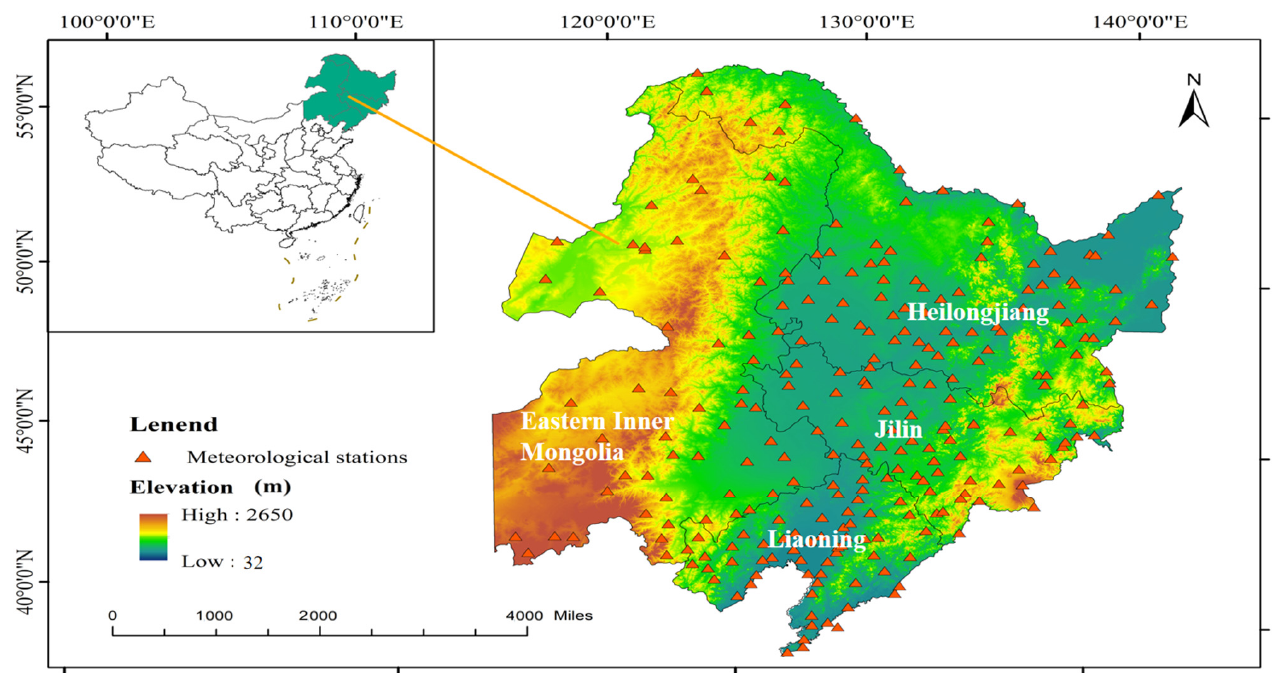
Figure 1. Map of the study area showing elevation (m) and the meteorological stations used in the study; the inset is the location of Northeast China within the country.